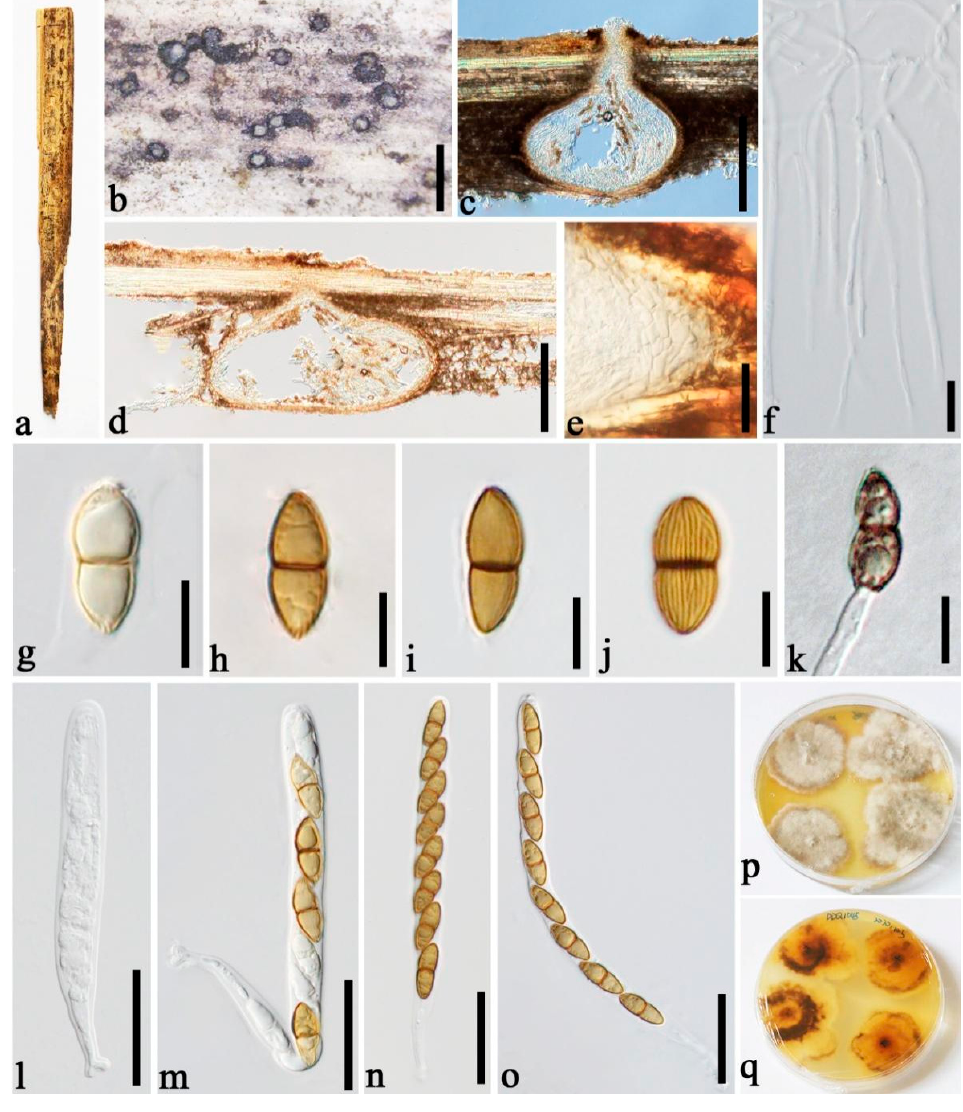
Figure 10. Roussoella sinensis (GMB1296, holotype). ( a ) Bamboo specimen; ( b ) black ascostromata showing black ostioles with openings on host surface; ( c , d ) vertical section of ascostromata; ( e ) cells of locule wall; ( f ) pseudoparaphyses; ( g – j ) ascospores; ( k ) germinating ascospore; ( l – o ) different developmental stages of asci; ( p , q ) cultures on PDA from above and below. Scale bars: ( c , d ) = 200 µ m, ( e ) = 50 µ m, ( f ) = 10 µ m, ( g – k ) = 15 µ m, ( l – o ) = 30 µ